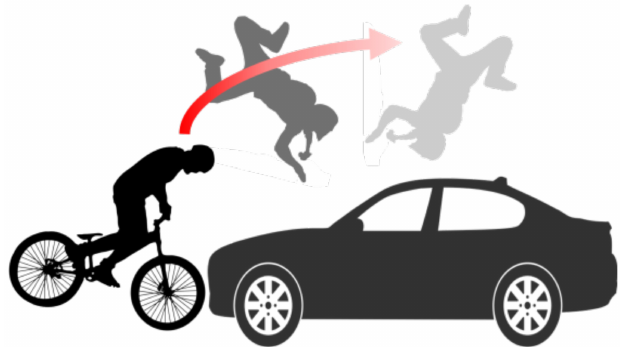
Figure 6. Sequential accident